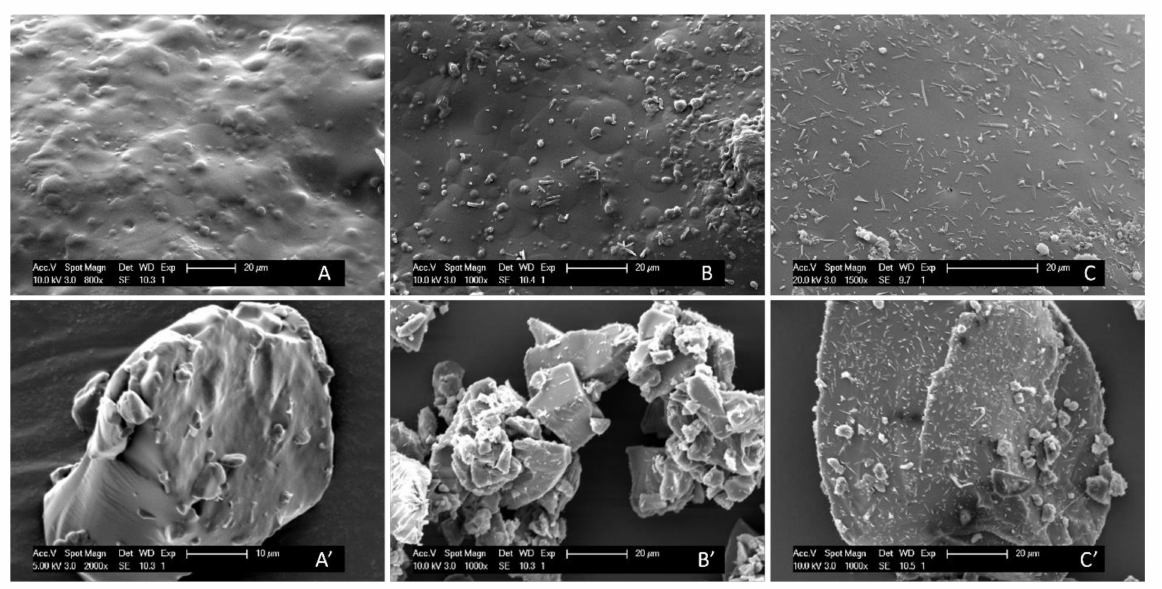
Figure 4. SEM images of the surface of NAP–PVP-VA-coated pellets with ( A ) 40% NAP load, ( B ) 45% NAP load and ( C ) 50% NAP load. SEM images of milled NAP–PVP-VA-coated pellets with ( A’ ) 40% NAP load, ( B’ ) 45% NAP load and ( C’ ) 50% NAP load.